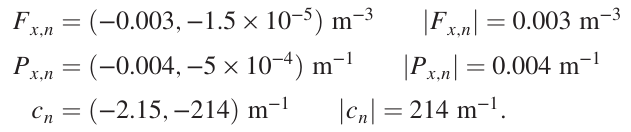
FIG. 13. Evolution of normalized square root of vertical action from tracking corresponding to initial conditions y ¼ 28 σ y ¼ 50 σ , y ¼ 58 σ . y y